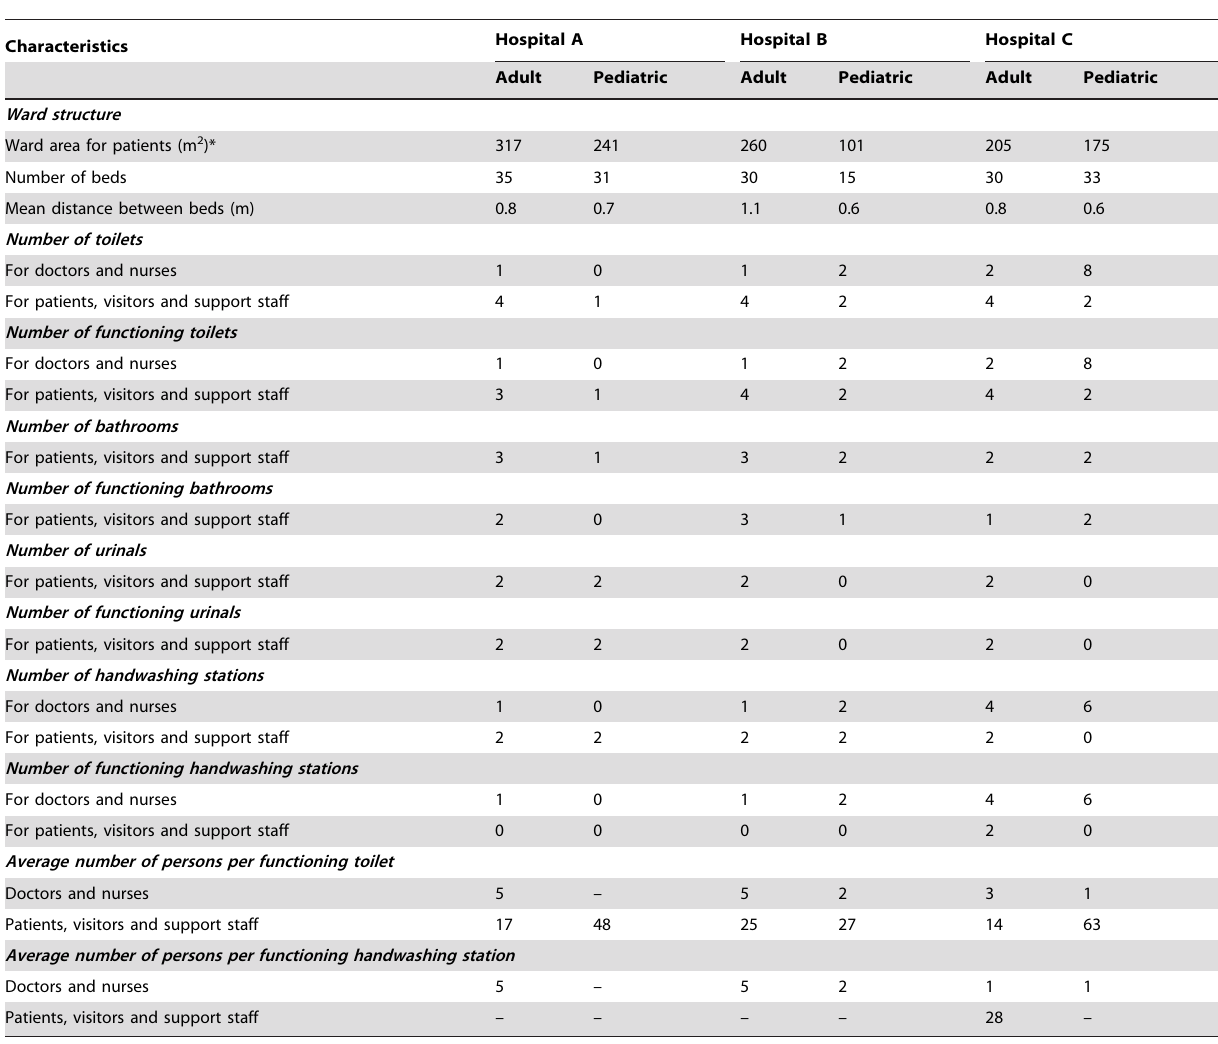
Table 1. Characteristics of six wards in three hospitals,